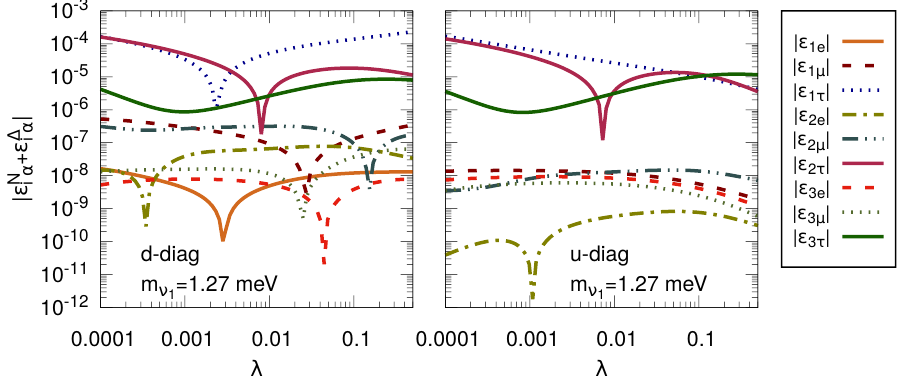
Figure 7 . CP-asymmetry vs. the quartic coupling in compact spectrum scenario. Left (right) panel corresponds to d ( u )-quark diagonal basis. The lightest neutrino mass is kept at m (cid:23) Other parameters are kept (cid:12)xed as described in the text.